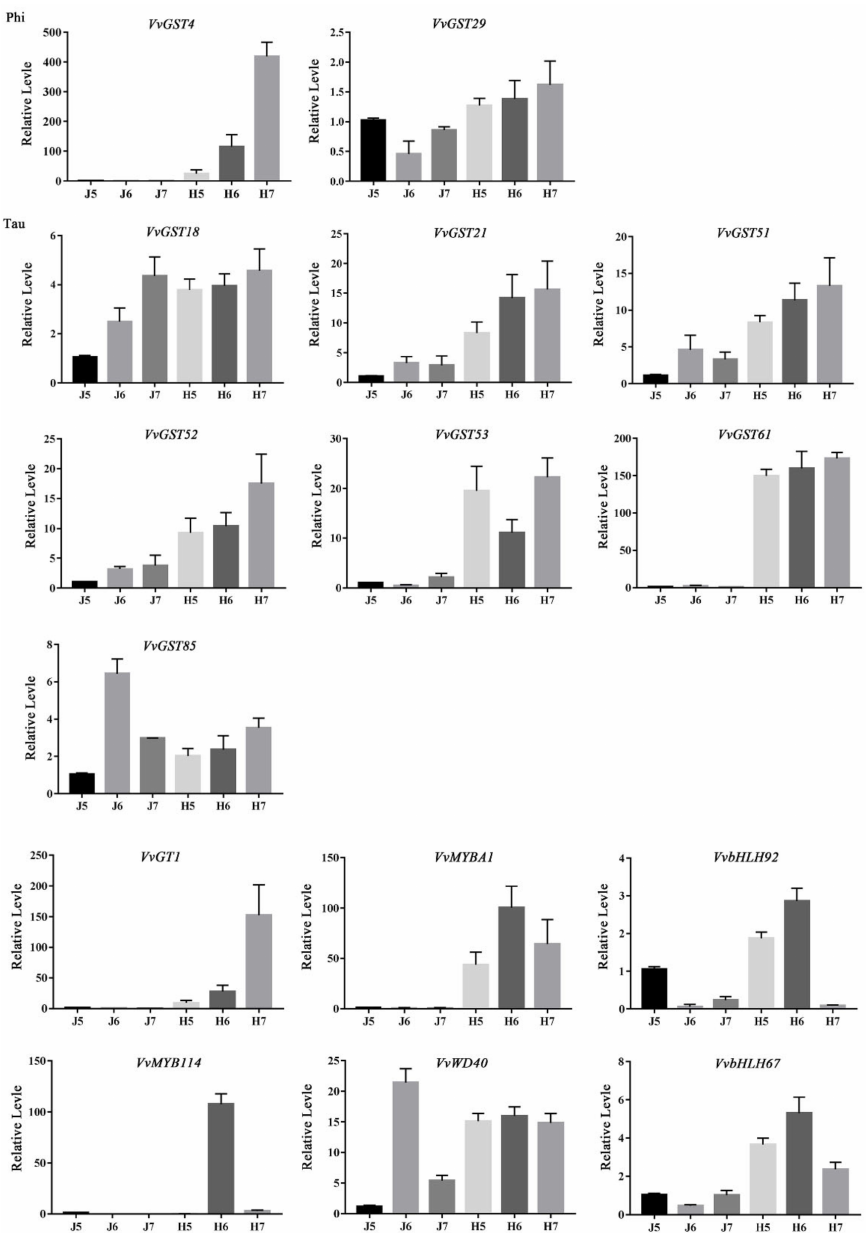
Figure 10. Verification of relative expression levels of genes in RNA-seq by qRT-PCR. The left y-axis represents the relative gene expression levels analyzed by